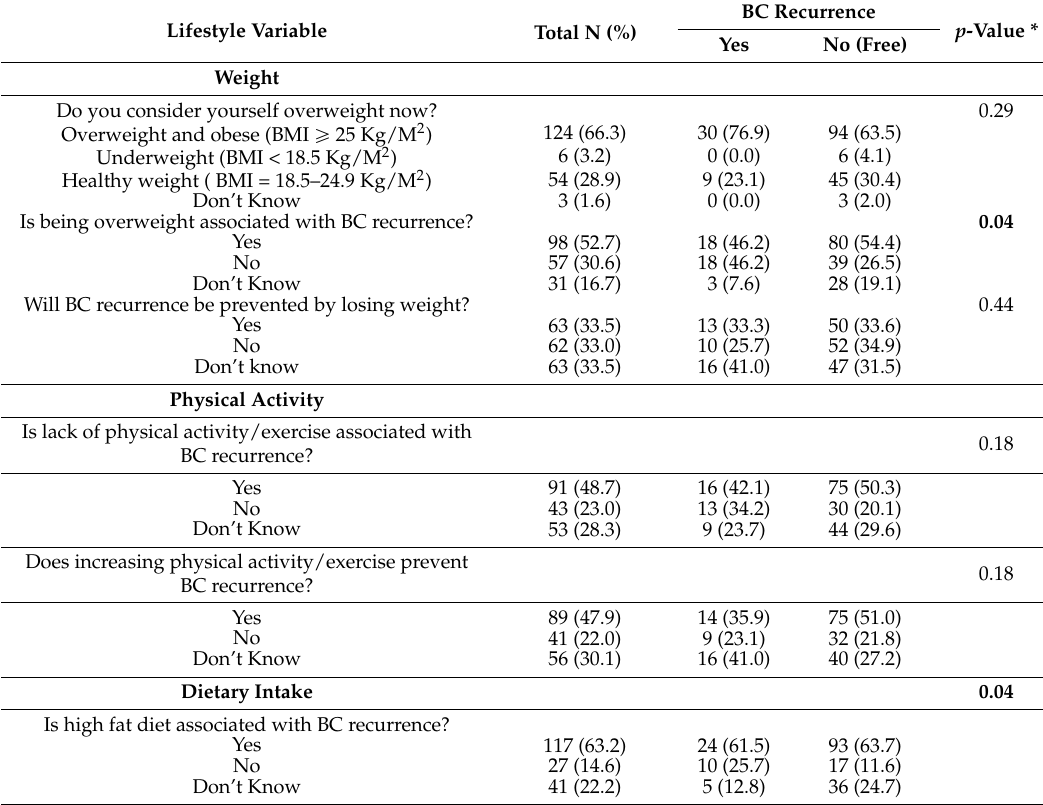
Table 2. Breast cancer recurrence risk reduction beliefs by breast cancer recurrence status. Lifestyle Variable Total N (%)